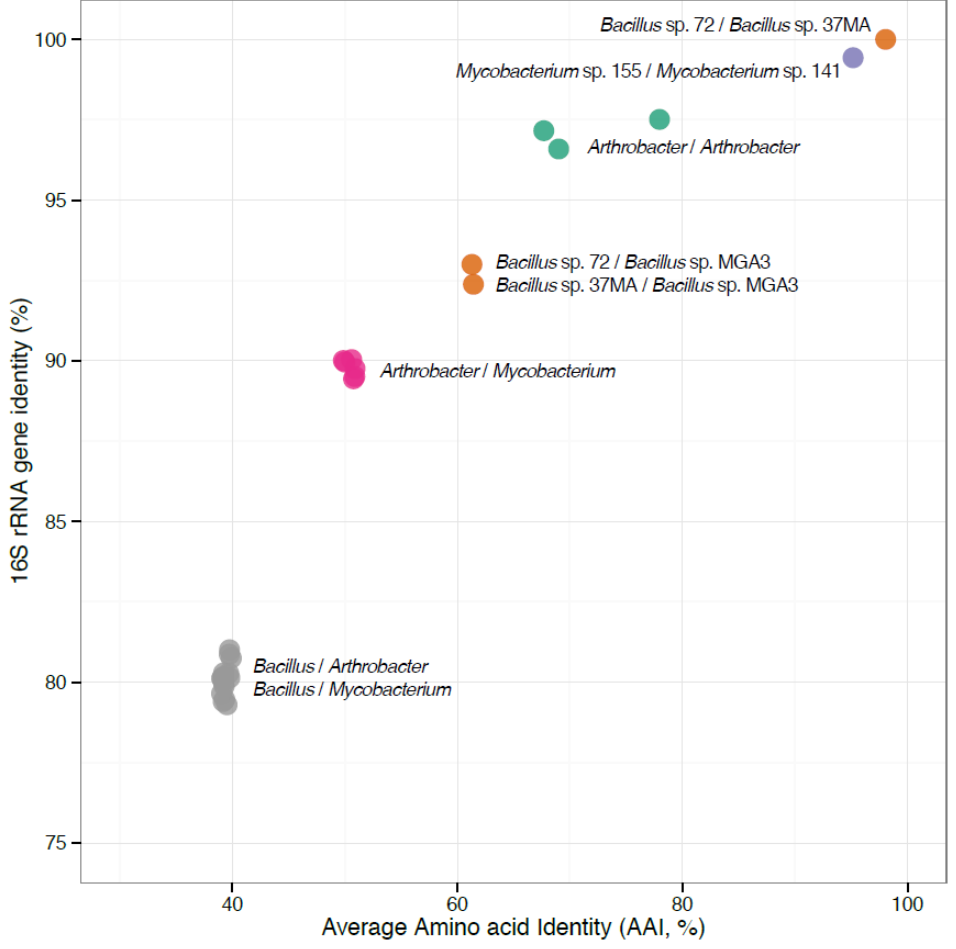
Figure 1. Phylogenetic relationships among the strains described. Each dot represents a comparison between two genomes and shows their 16S rRNA gene identity ( y -axis) plotted against the average amino acid identity (AAI) of the genes shared between the two genomes ( x